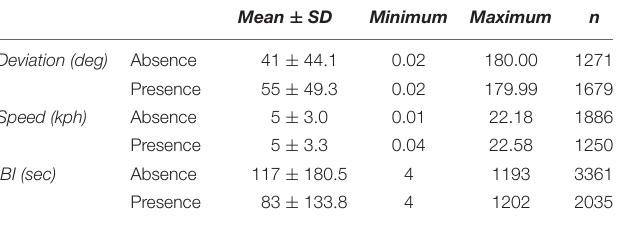
TABLE 4 | Summary statistics for movement and behavioral metrics, deviation, speed, and inter-breath interval (IBI).